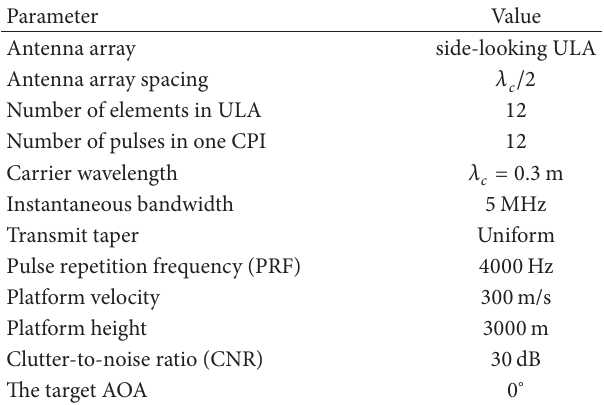
Table 1: Radar system parameters.